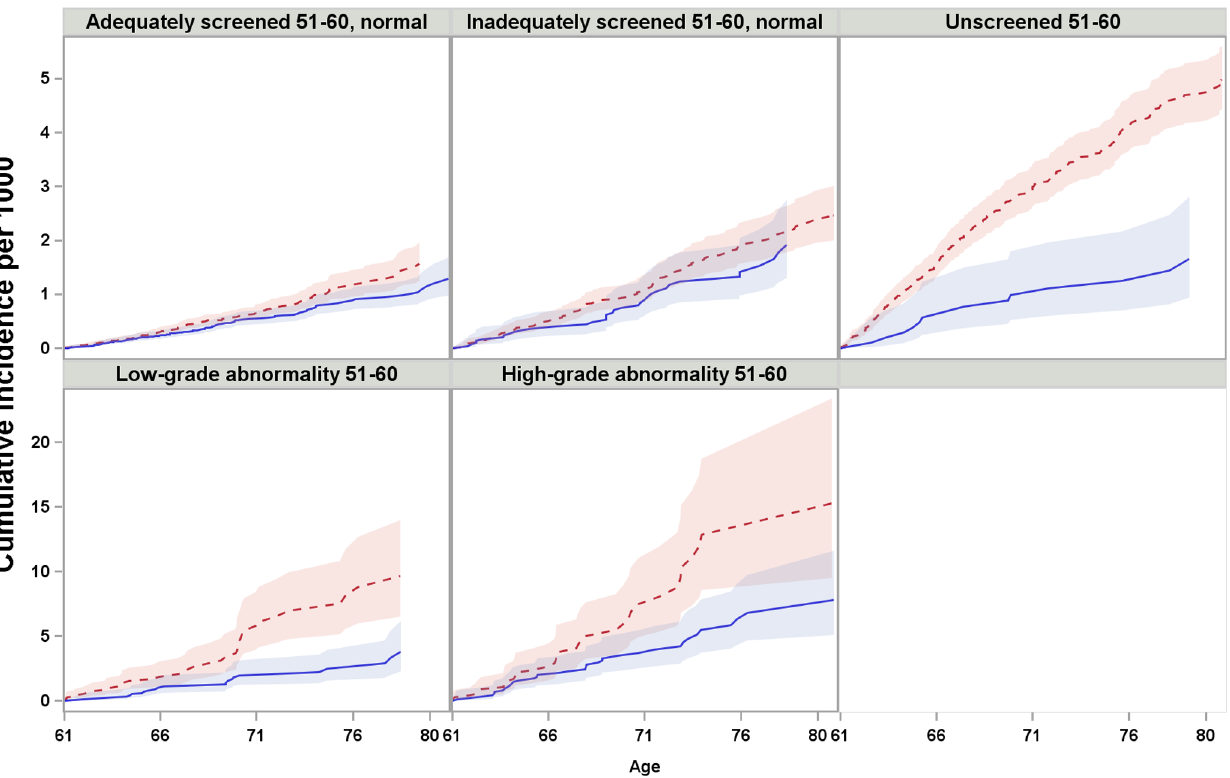
Fig 3. Cumulative incidence and 95% confidence intervals of cervicalcancer among women screenedand unscreened at age 61–65, by screening history at age 51–60, considering death and total hysterectomy as competing events. Red dotted line: unscreened at age 61–65; blue solid line: screened at age 61–65. Note that the scales of y -axis are different betweenthe first and second row.